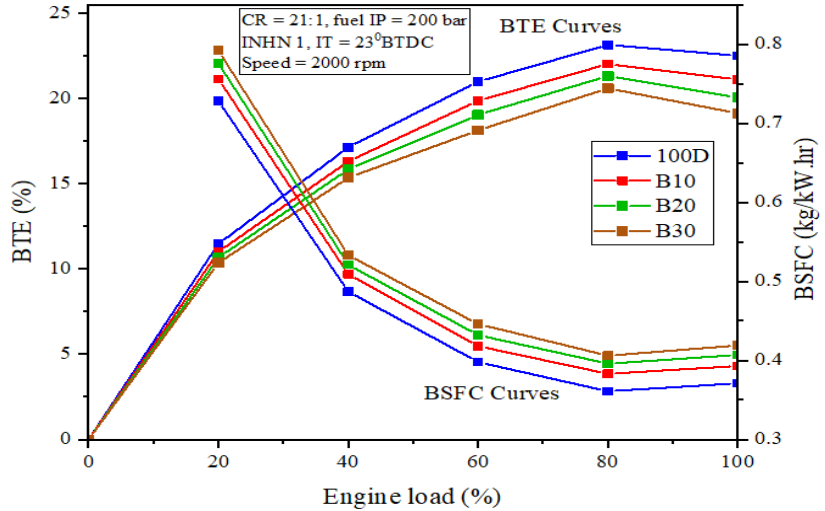
Figure 14. Influences of engine load on brake specific fuel consumption (BSFC) and brake thermal efficiency (BTE) for various test fuels.